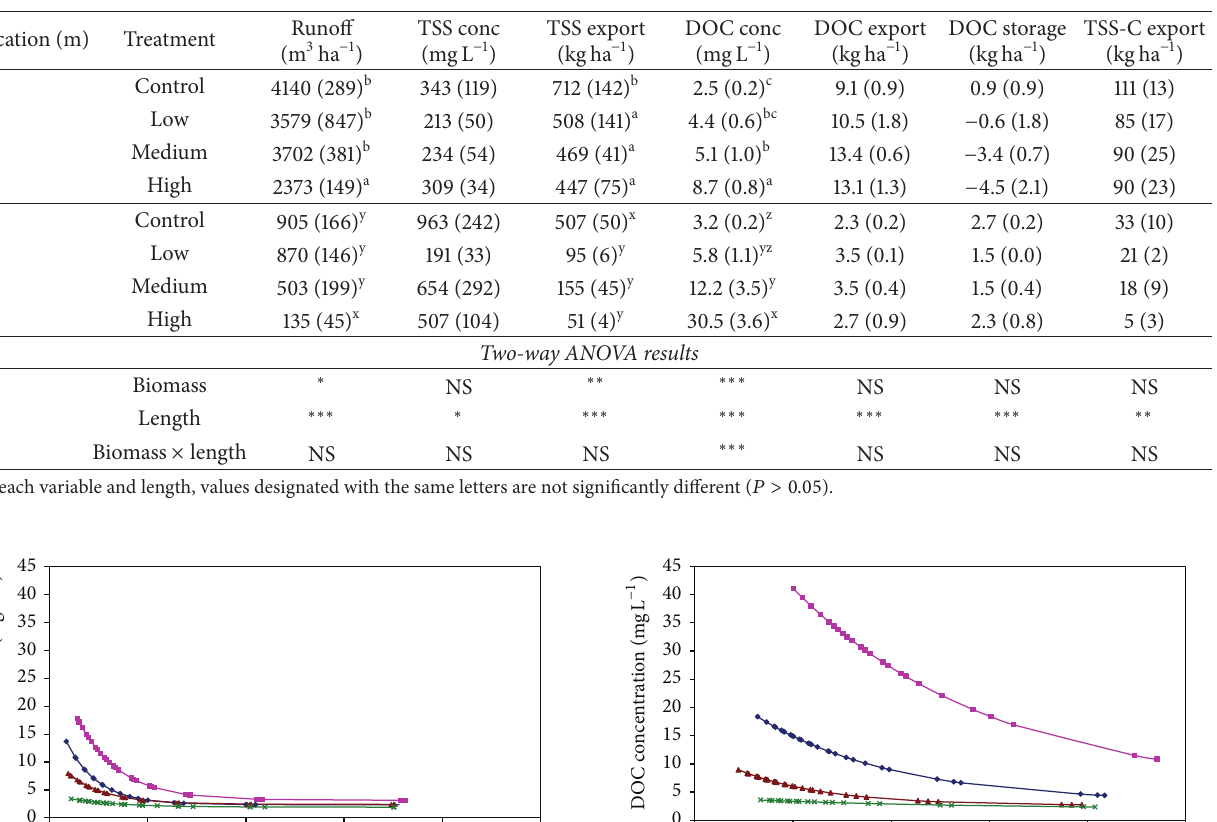
Table 2: Biomass residue and field length effects on runoff, TSS, DOC, and TSS-C in the 274 m long field. Shown are means (standard error), as well as analysis of variance results. 𝑛 = 3 .